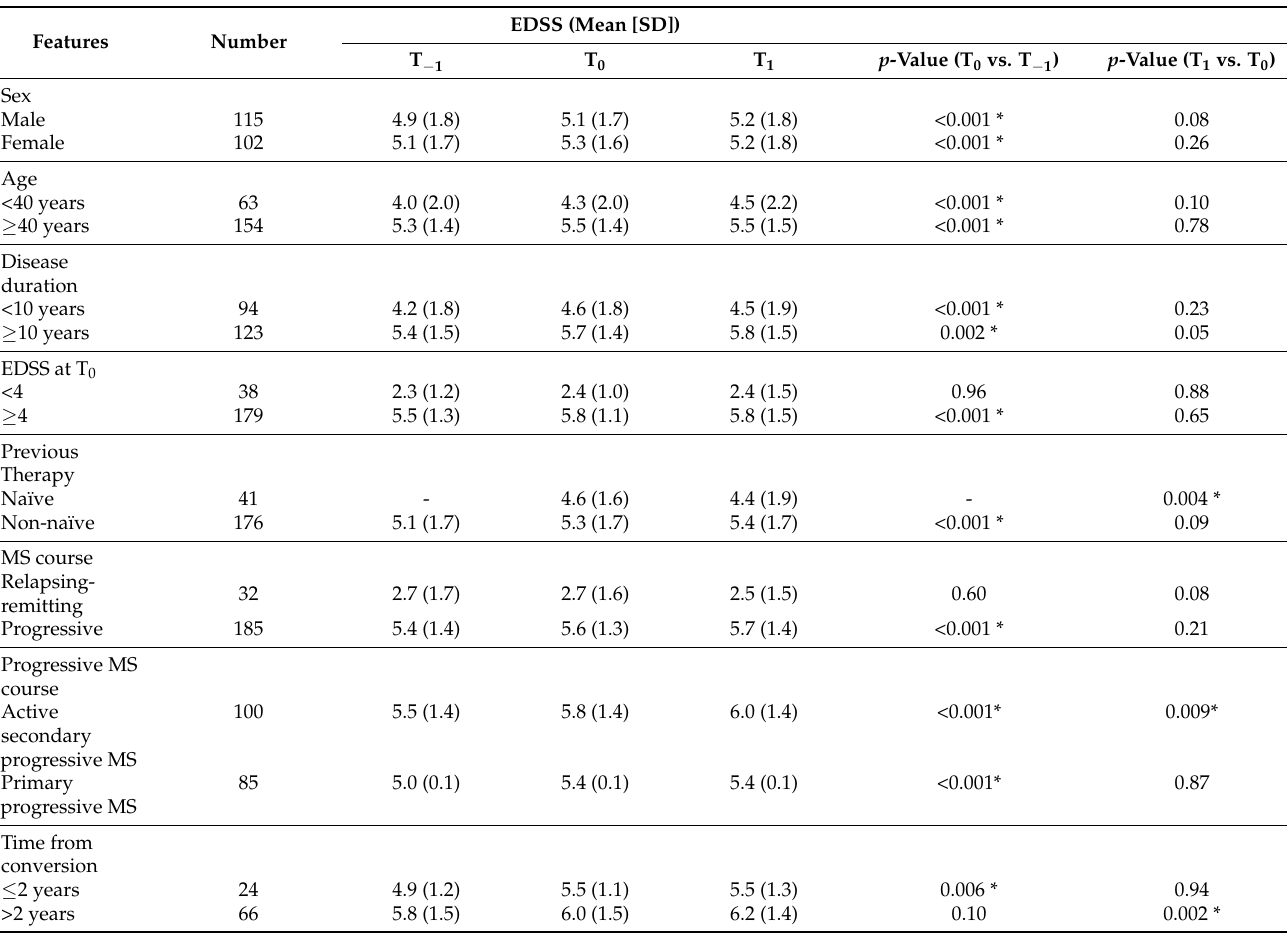
Table 2. Post-hoc effectiveness